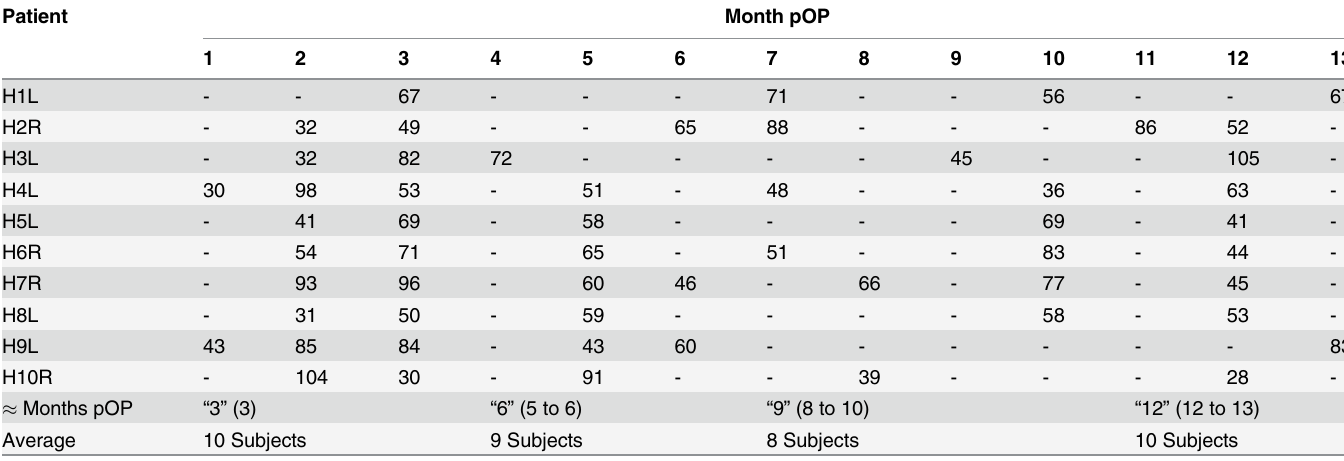
Table 2. Number of averaged steps at postoperative months 1 to 13.